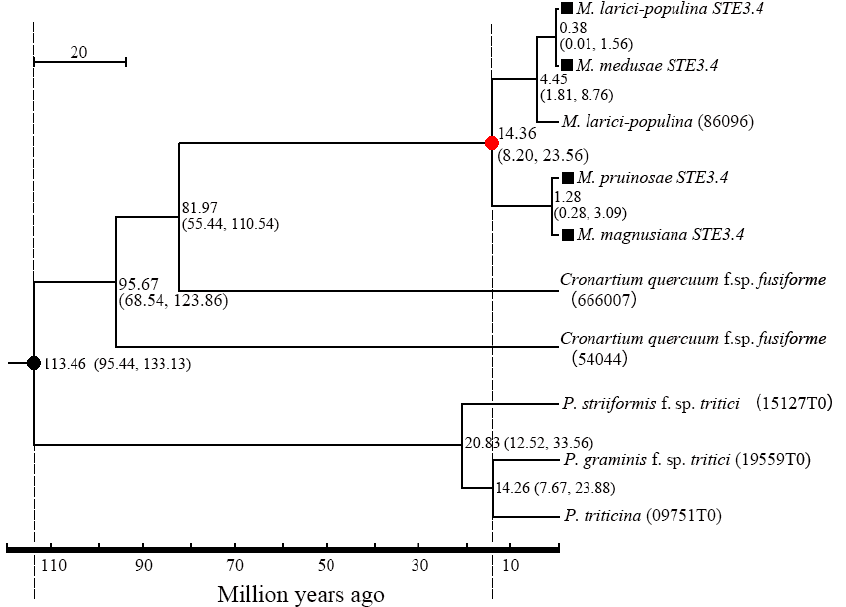
Figure 4. Divergence time between macrocyclic rusts and hemicyclic rusts. Dark dot “●” refers to the calibrate time based on the divergence time between P. striiformis f. sp. tritici and M. larici-populina; Red dot “●” refers to the divergence time of the tested rusts in this study; ■ : the tested rusts; parentheses refers to 95% confidence for the pair’s diverged time. The 74th locus at the conserved transmembrane domain of the STE3.3 in hemicyclic rusts is a positive selection site, which mutated from L (in the macrocyclic rusts) to F. The 387th site in the hemicyclic rusts STE3.4 protein was mutated from Y (in the macrocyclic (Supplementary Figure S1).